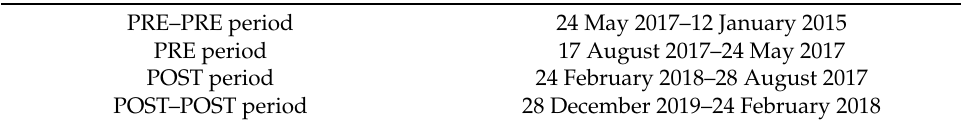
Table 1. Time periods of observation of vertical ground deformation velocity (see text for details).